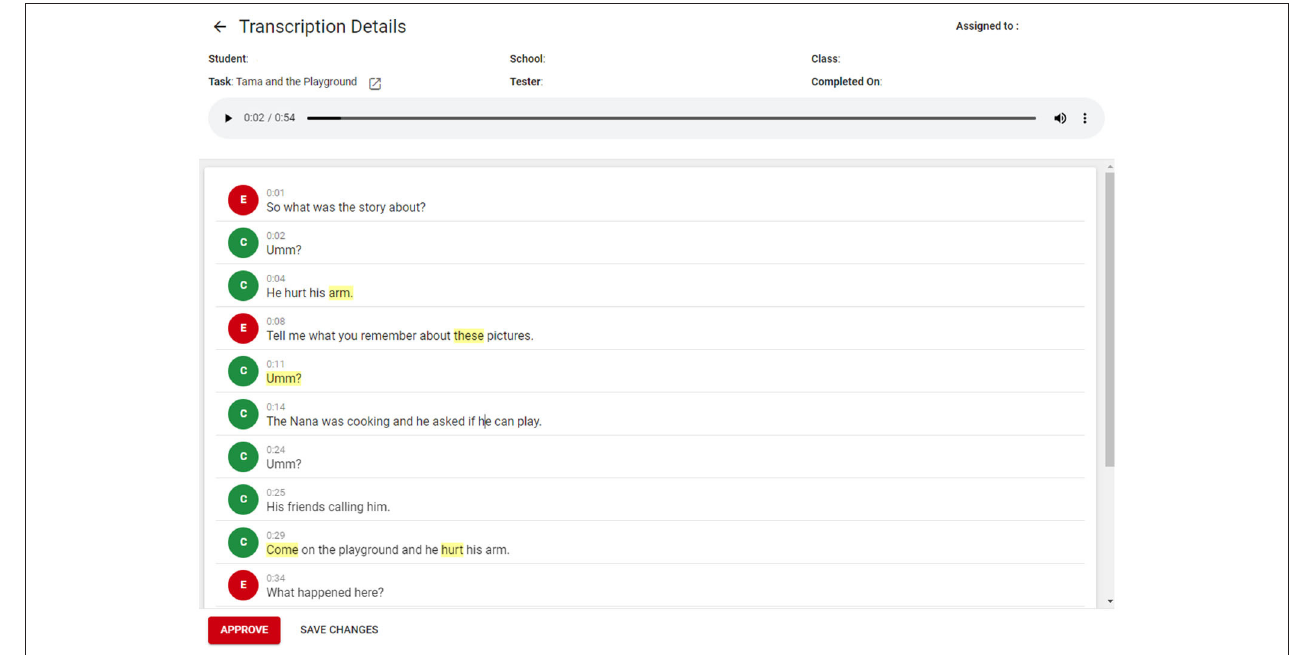
FIGURE 3 | Screenshot from the automatic transcription and editing tool. Reproduced with permission from UC Child Well-being Research